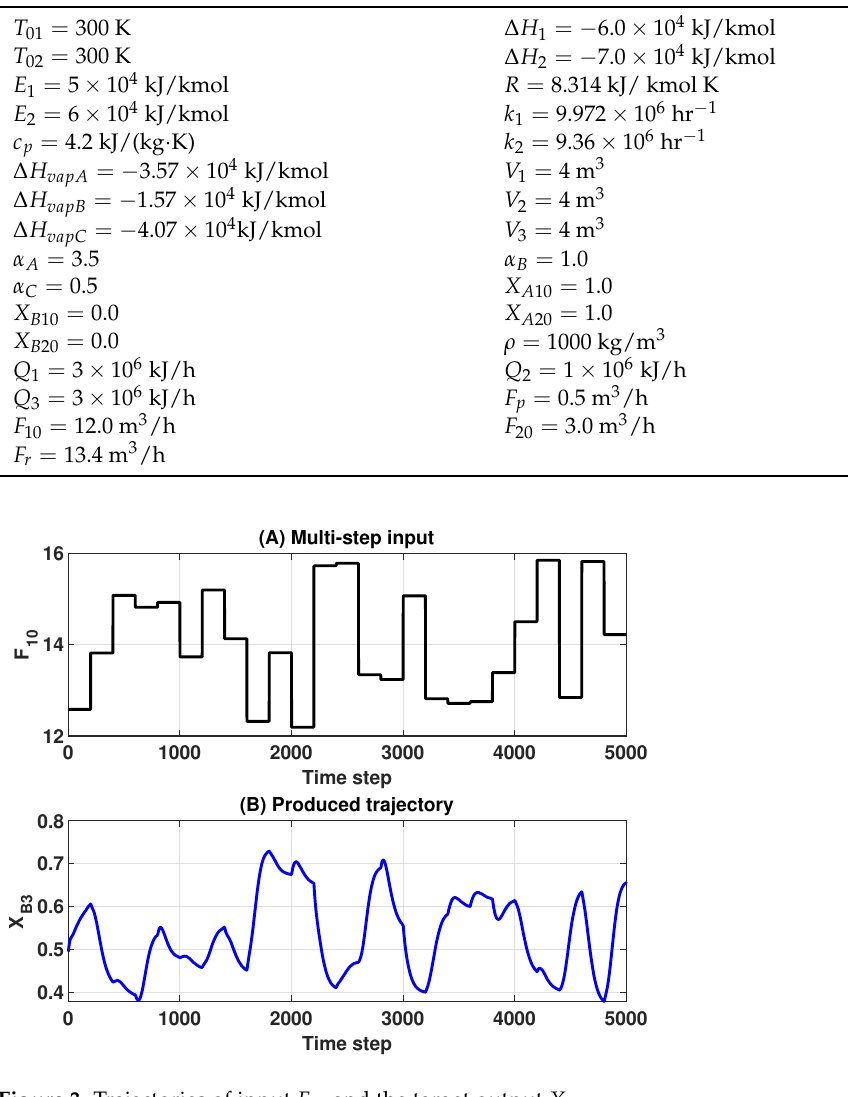
Figure 3. Trajectories of input F 10 and the target output X B 3